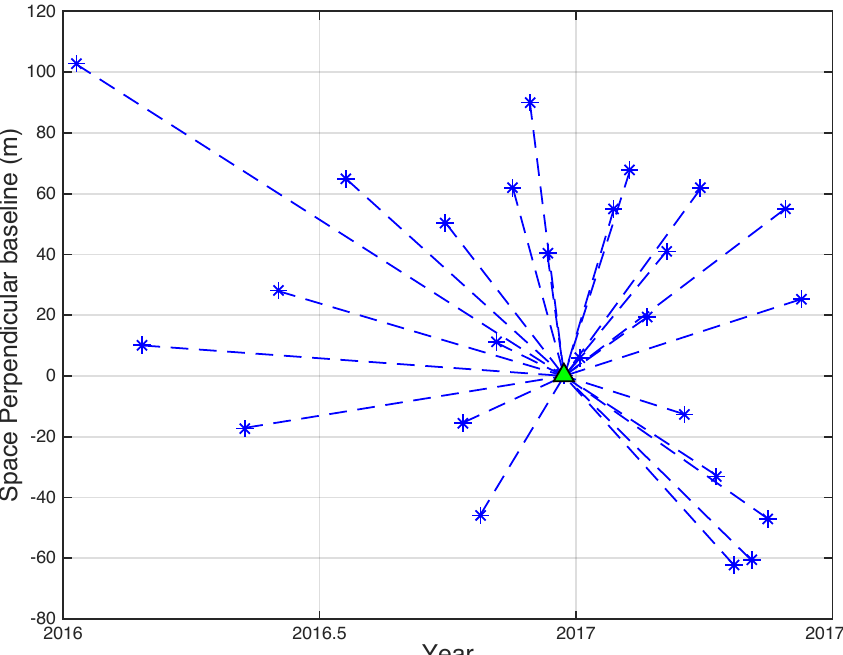
Figure 3. Temporospatial baseline distribution of ascending Sentinel-1A interferograms. The vertical axis shows the space perpendicular baseline in metres, the horizontal axis shows the image acquisition dates. All of the baselines represent interferometric pairs used for the time-series analysis. The green triangle represents the master image and the blue asterisks represent the slave